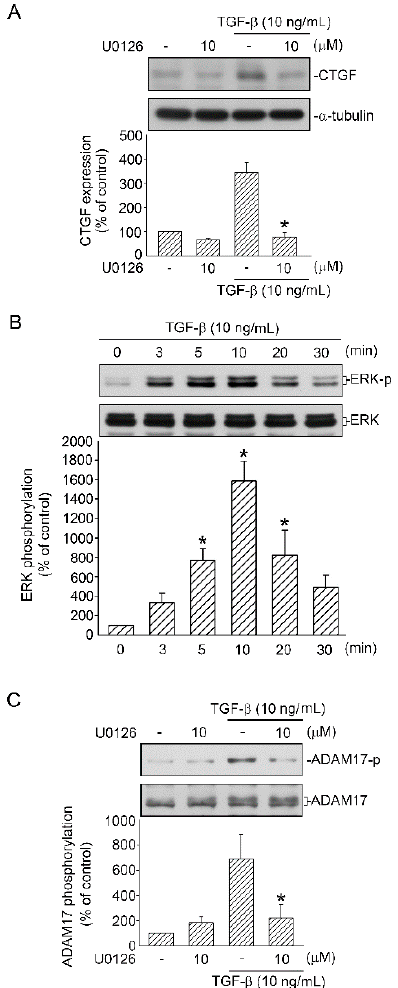
Figure 3. Participation of ERK in TGF- β -induced CTGF expression and ADAM17 activation in human lung epithelial A549 cells. ( A ) Cells were processed with the ERK inhibitor U0126 (10 µM) for 20 min before they were stimulated with TGF- β (10 ng/mL) for an additional 6 h. CTGF or α -tubulin in cell lysates were immunodetected with specific antibodies. Data are expressed as mean ± SEM of three independent experiments. * p < 0.05, compared with the TGF- β group without U0126 treatment. ( B ) A549 cells were stimulated with TGF- β (10 ng/mL) for 0–30 min, and then the levels of ERK